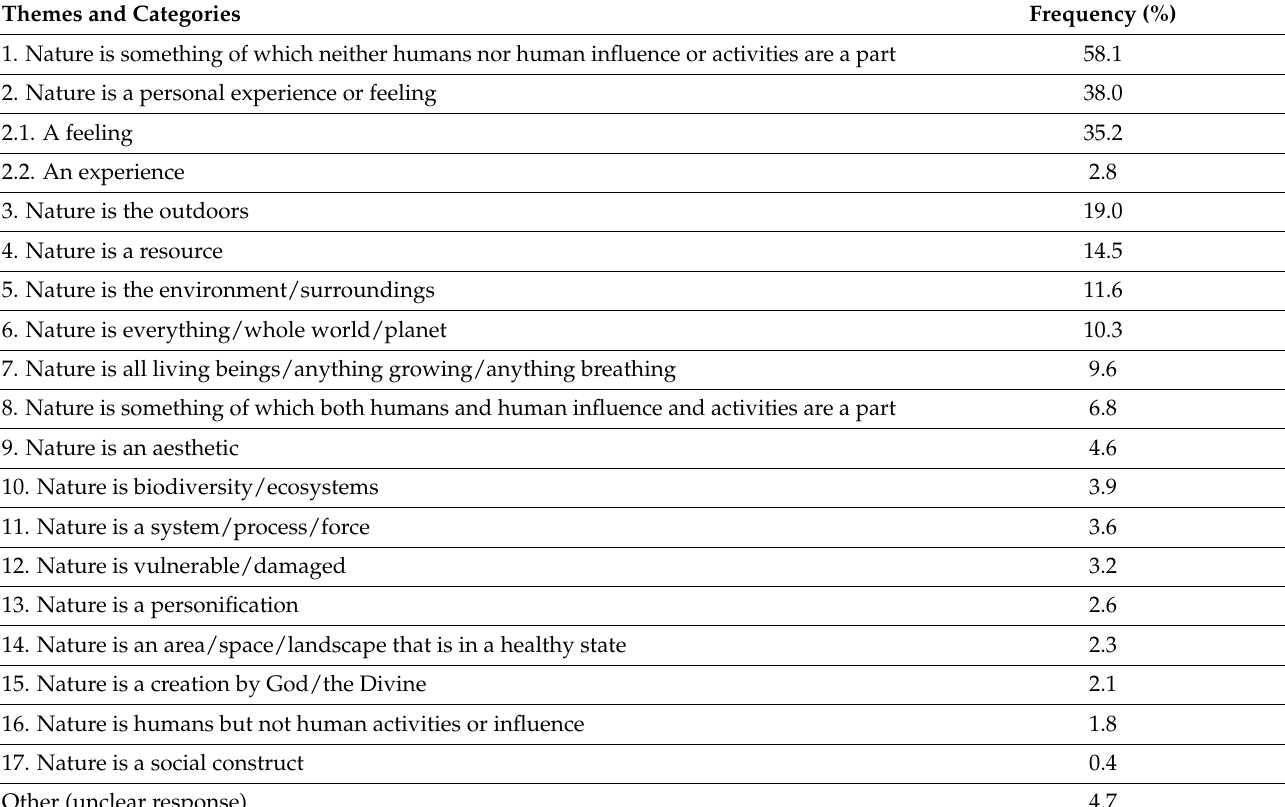
Table 1. Conceptions of ‘nature’. Frequency reflects the percentage of respondents who referenced each theme/category. N.B the total(s) add up to over 100.0 percent because respondents often referenced more than one theme/category.